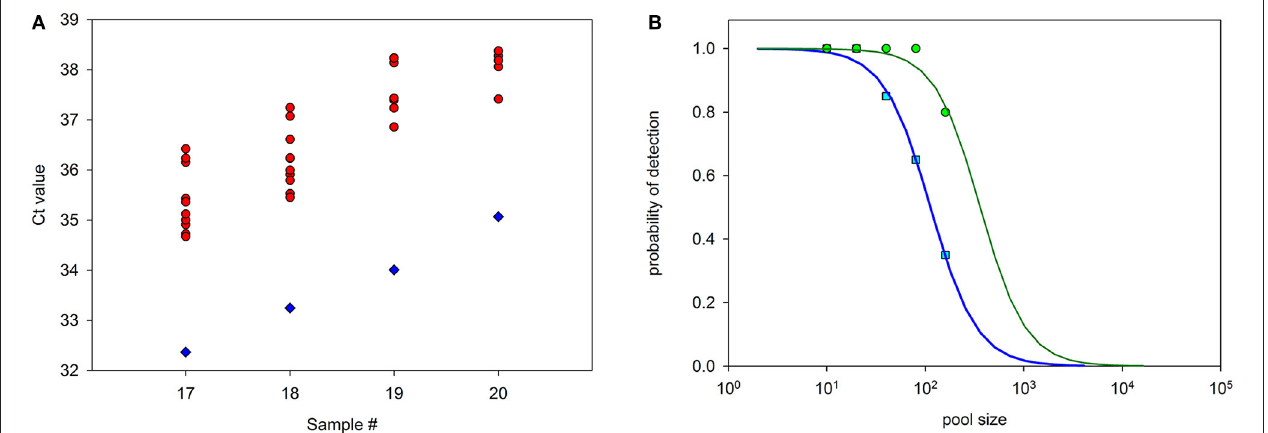
FIGURE 3 | Probability of detection of samples included in pools of different sizes. Samples #17 to #20, which possessed the highest Ct values, were diluted 1:20 with negative samples and measured. (A) Diamonds: Original Ct (ORF1) from samples #17 to #20. Circles: Ct values from 10 replicates of the same samples diluted 1:20 with negative samples and measured. Detection with Ct < 40 was positive in all dilutions of samples #17 and #18, 7 out of 10 dilutions of sample #19, and 5 out of 10 dilutions of sample #20 (circles with the same Ct value appear superimposed). (B) Probability of detection, as determined in 20 replicas as before, for pools containing one positive sample of Ct = 31.7 (ORF1) diluted at 1:10 to 1:160 with negative samples. Blue squares: ORF1 gene. Green circles: N gene. Lines are best fits of sensitivity curves.